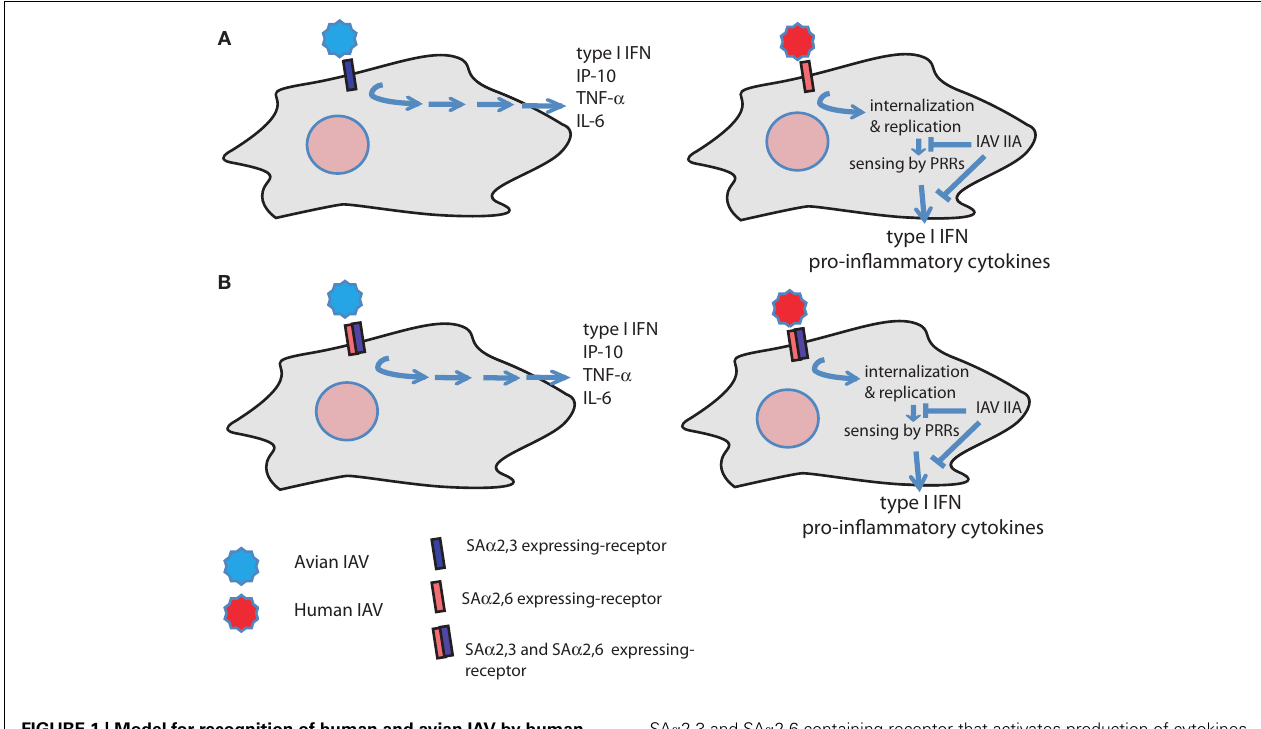
FIGURE 1 | Model for recognition of human and avian IAV by human immune cells. (A) IAV are recognized by separate receptors that are differently sialylated (SA α 2,3 and SA α 2,6). (B) IAV are sensed by an unknown